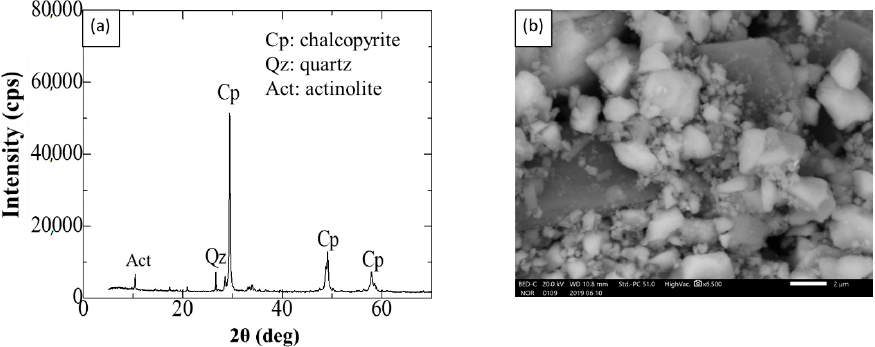
Figure 2. Chalcopyrite sample: ( a ) XRD patterns, and ( b ) SEM image.